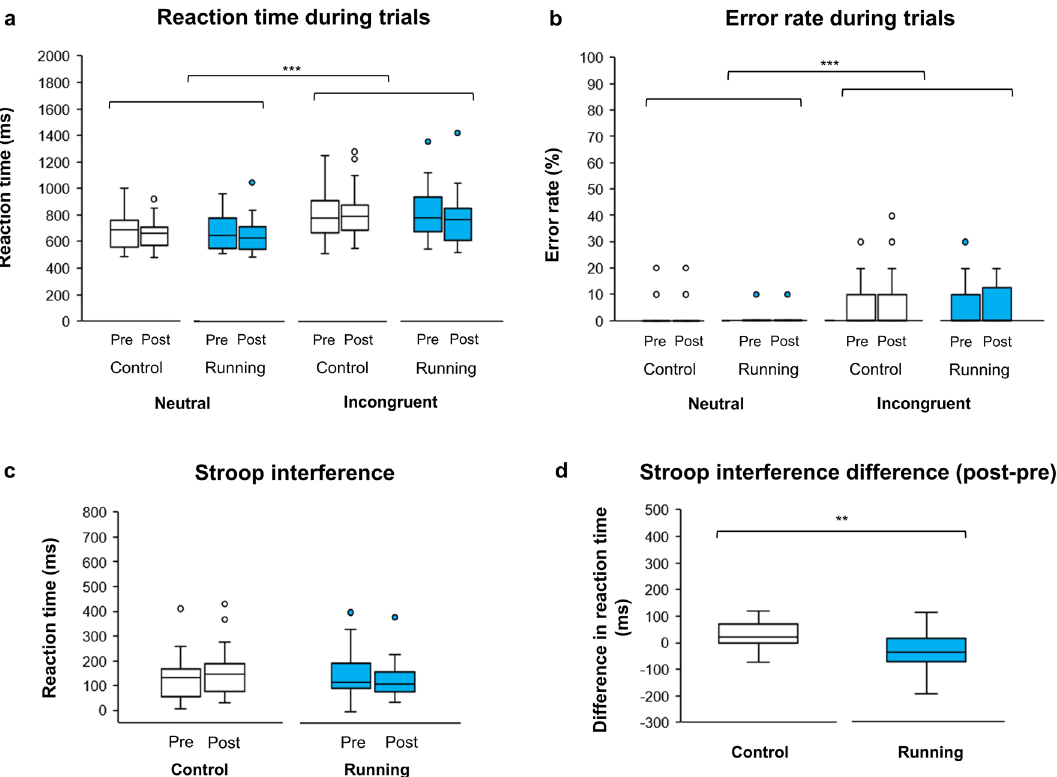
Figure 2. Comparison of Stroop task performance in ( a ) reaction time and ( b ) error rate between neutral and incongruent conditions. ( c ) Difference in Stroop interference [incongruent—neutral] between control and running sessions. ( d ) Contrast in Stroop interference difference ([incongruent—neutral of post-session]— [incongruent—neutral of pre-session]) between control and running. The bottom, middle and top lines of each box indicate the 25th, 50th (median) and 75th percentiles, respectively. Whiskers above and below each box refer to the most extreme point within 1.5 times the interquartile range. Points above the whiskers are outliers. *** = p < 0.001, ** = p <